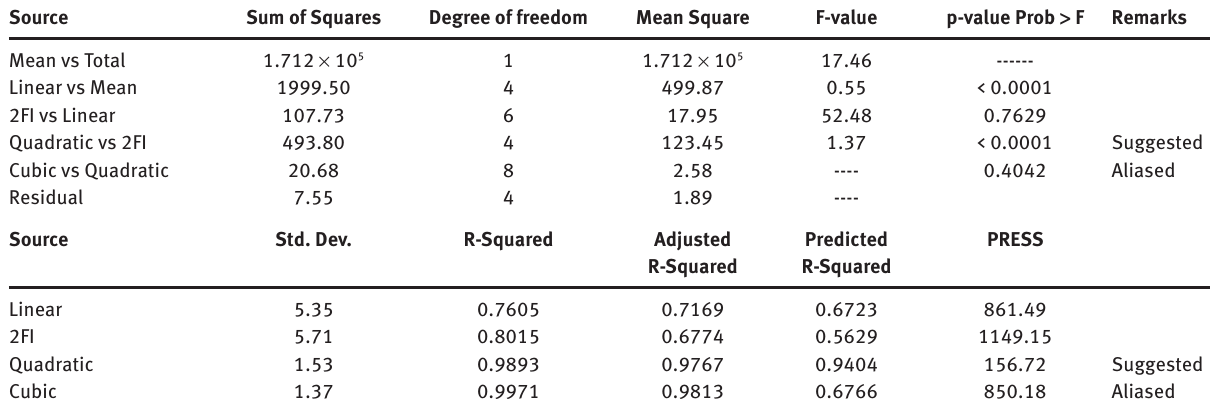
Figure 4: Diagnostic plot the model for manganese leaching: (a) normal % probability versus studentized residuals, (b) studentized residuals versus run number, (c) predicted versus actual data. Table 4: Adequacy of the